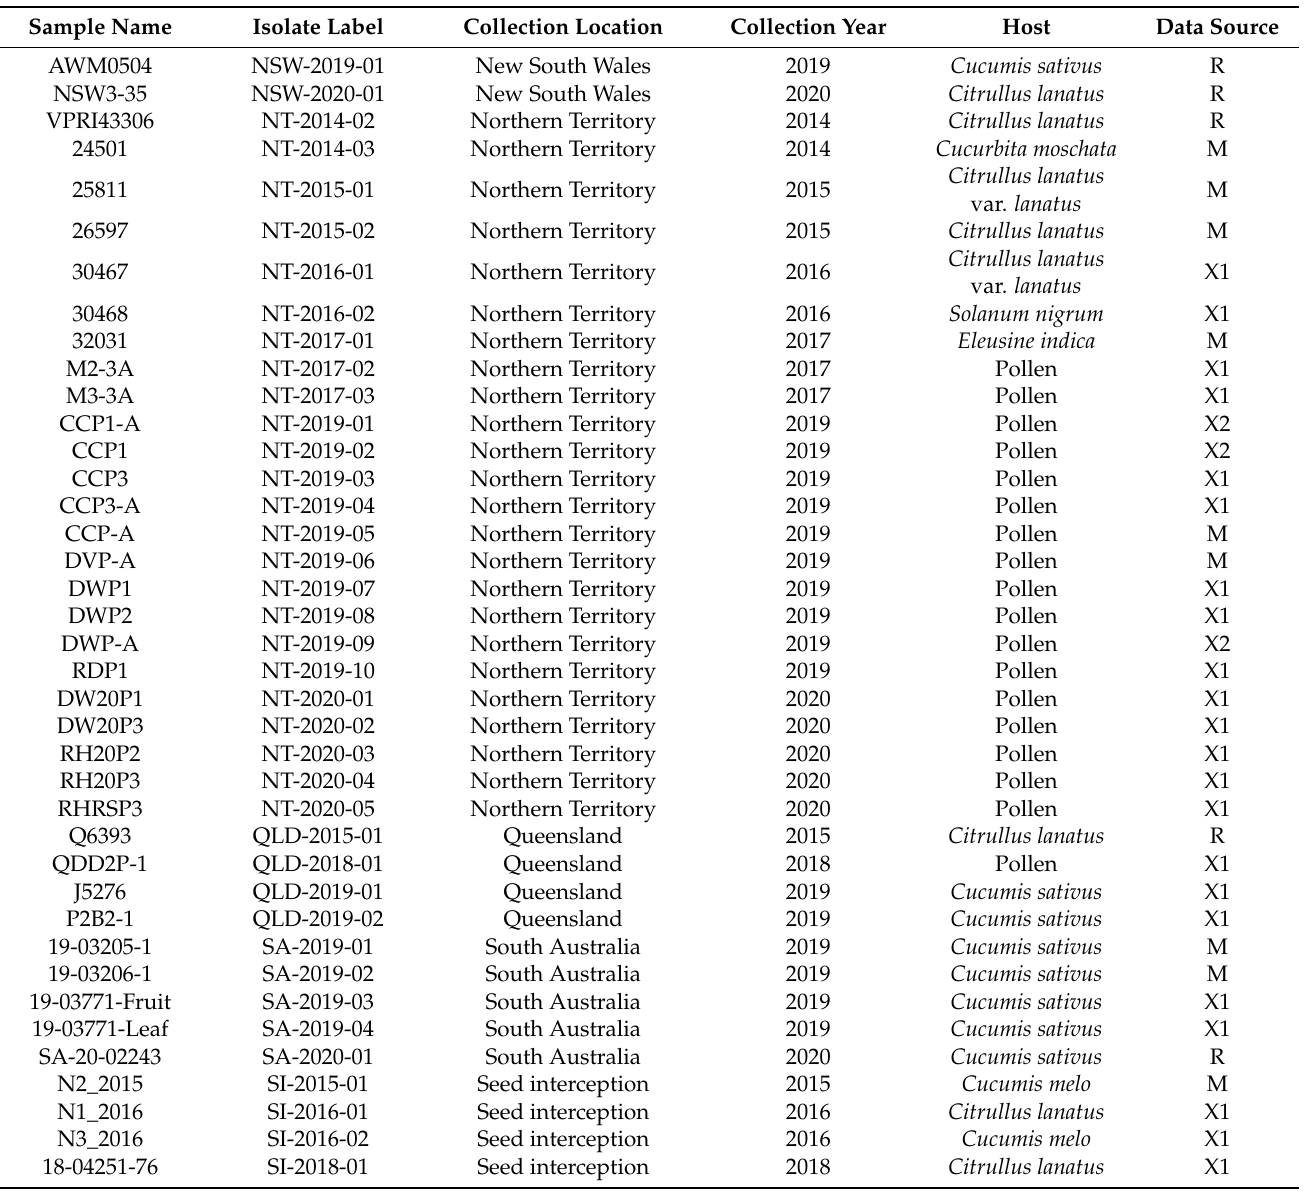
Table 1. The Australian and seed interception cucumber green mottle mosaic virus (CGMMV) isolates used to generate genome sequences for this